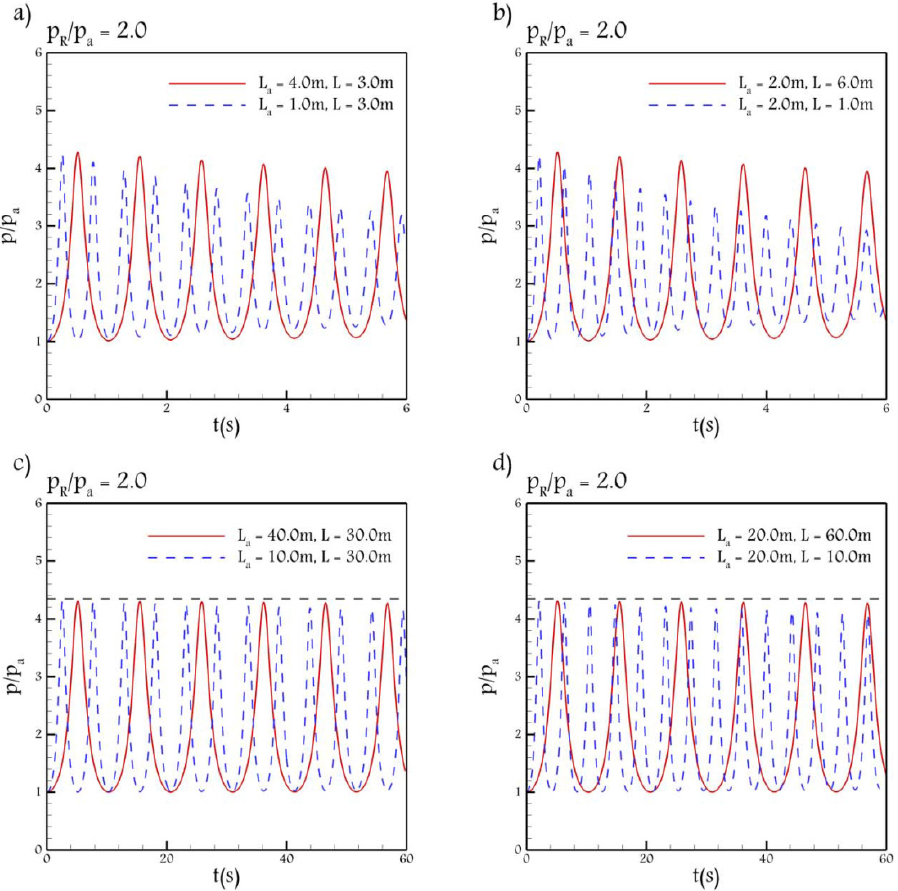
Figure 2. The non-dimensional air absolute pressure (p p (cid:2911) ⁄ ) distribution vs. the time, calculated by the backward Euler scheme, for the reservoir pressure ratio (p (cid:2902) p (cid:2911) ⁄ ) of 2.0, and ( a ) and ( c ) dif- ferent air initial lengths, ( b ) and ( d ) different water initial lengths.